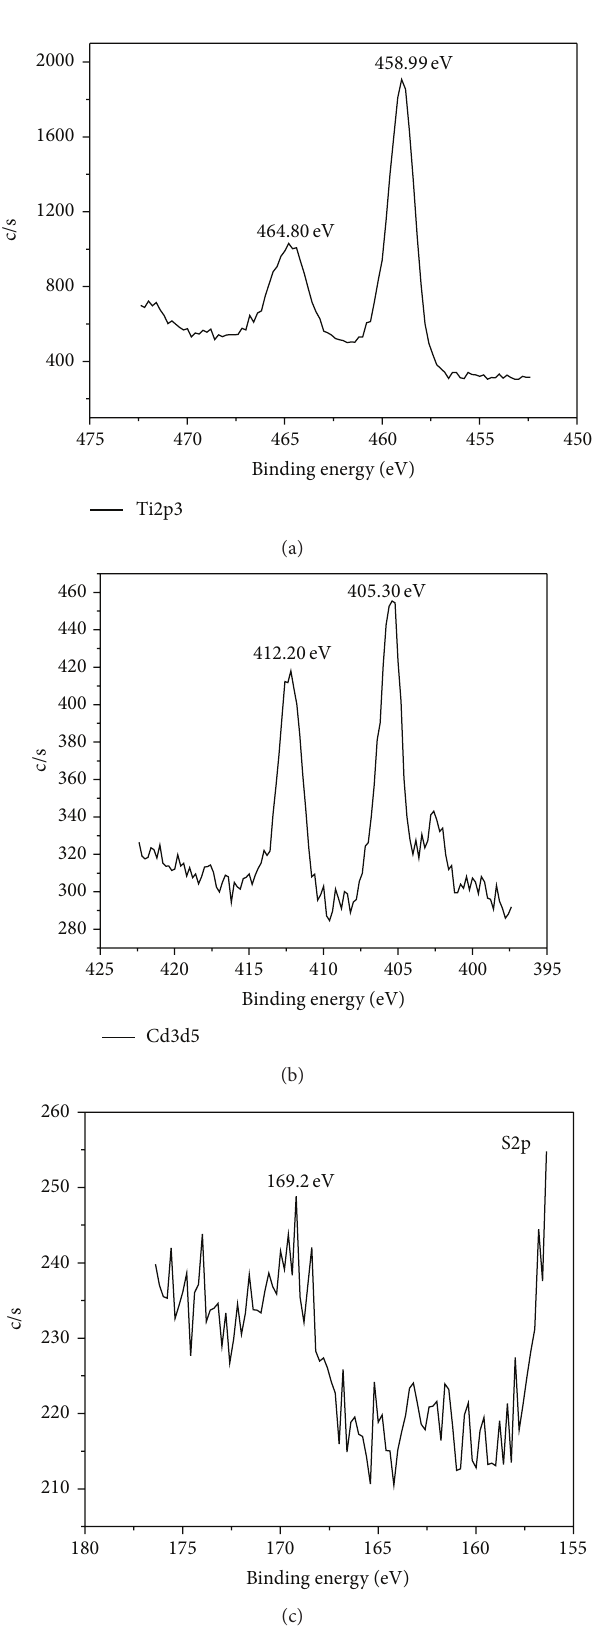
Figure 5: The XPS spectrums of Ti2p3 (a), Cd3d5 (b), and S2p (c) in CdS/TiO 2 -MMT-2.